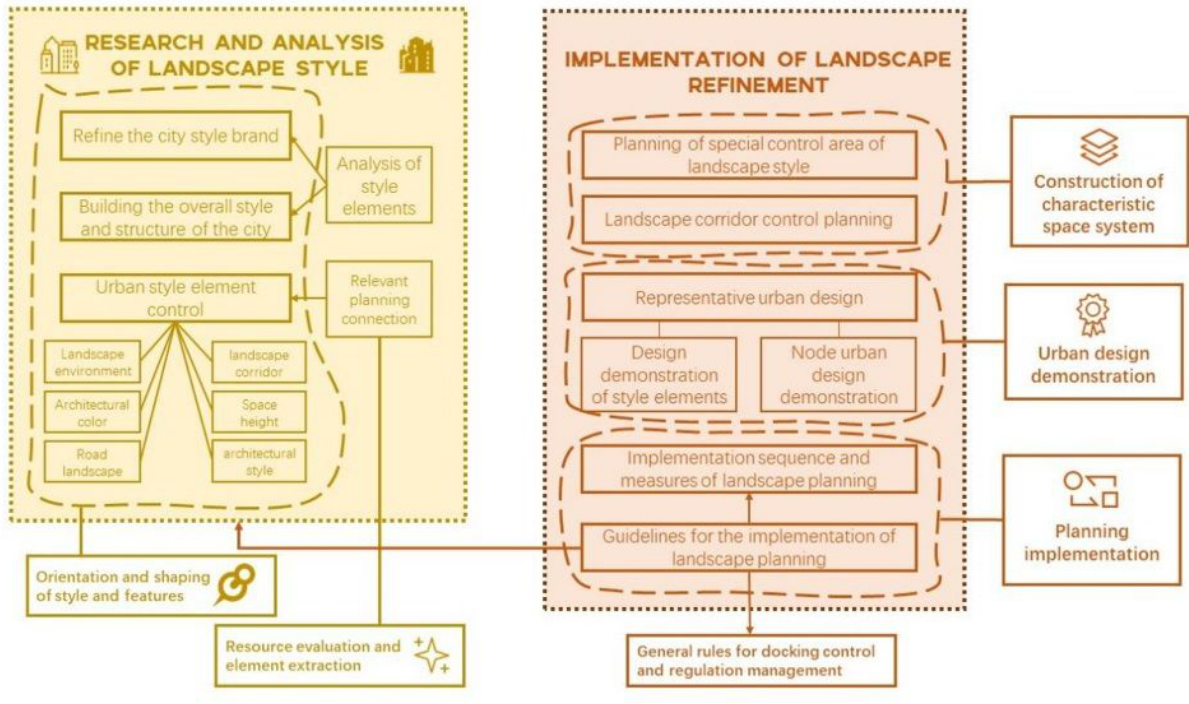
Figure 1: Nonlinear landscape design